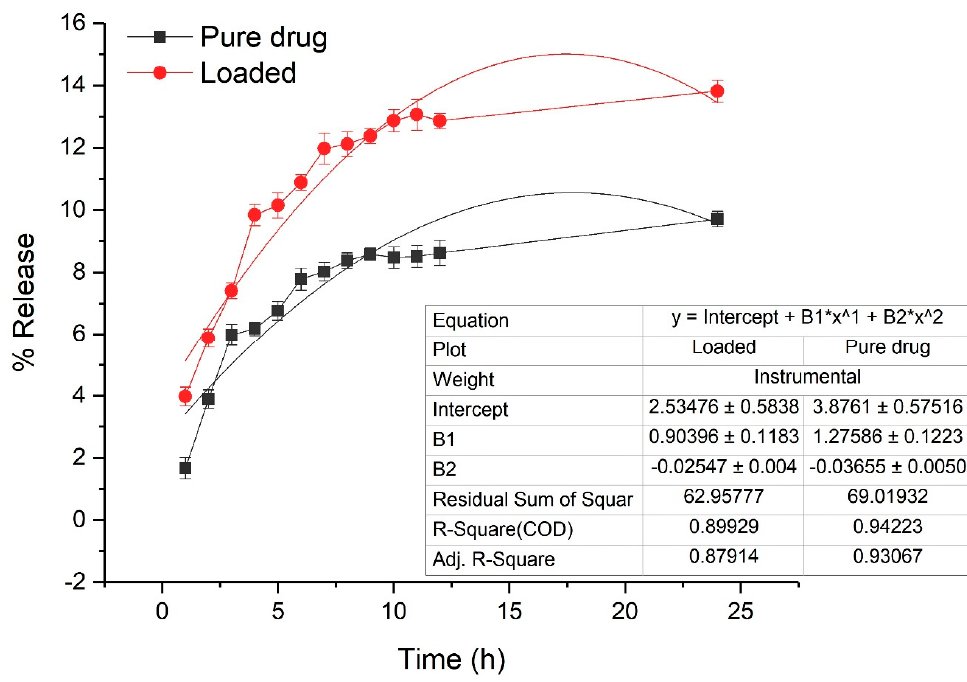
Figure 9. In vitro drug releases at a different time interval 270 Figure 10. In vitro drug releases at di ff erent time intervals.